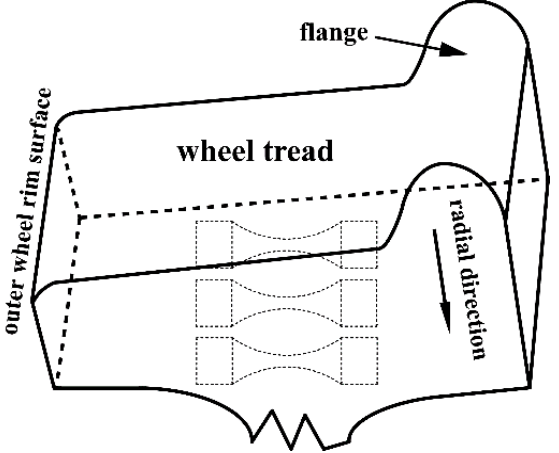
Figure 1. Schematic of wheel rim.